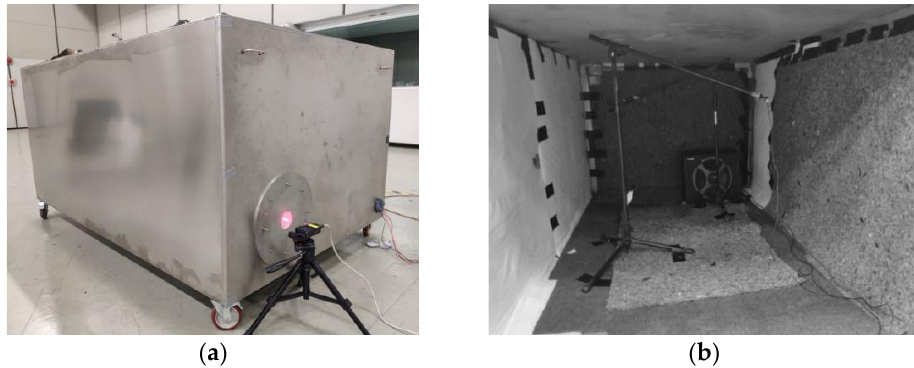
Figure 7. The experimental set-up. ( a ) The cavity, the membrane and the laser rangefinder. ( b ) The cavity interior and locations of the excitation and microphone with wall acoustic materials.